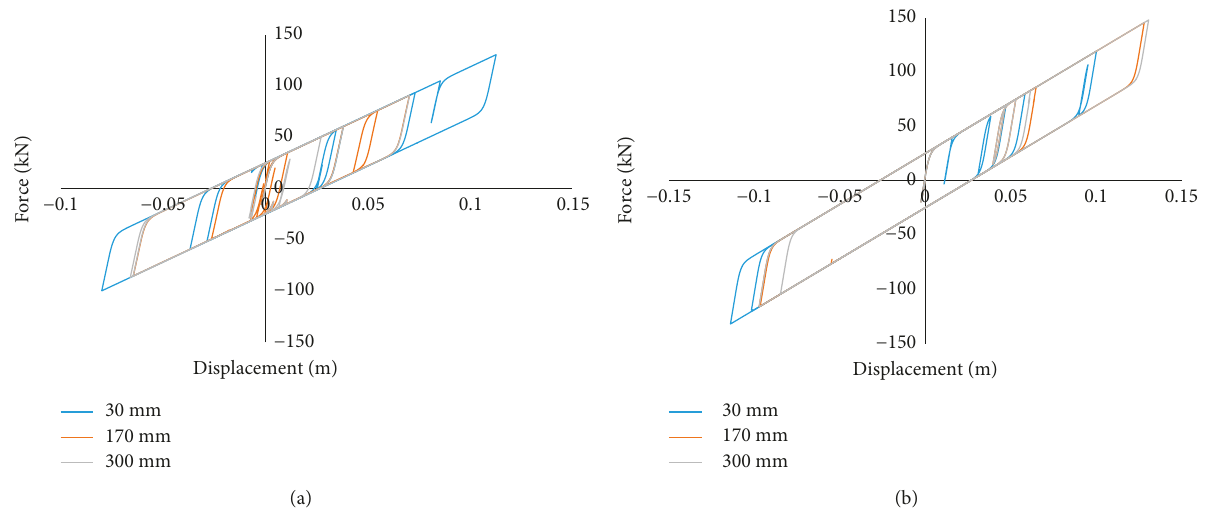
Figure 24: Hysteresis behaviour of LRB devices considering different seismic gaps. (a) Shorter building. (b) Taller building. Table 9: Summarized responses of fully BI adjacent buildings considering seismic gaps.